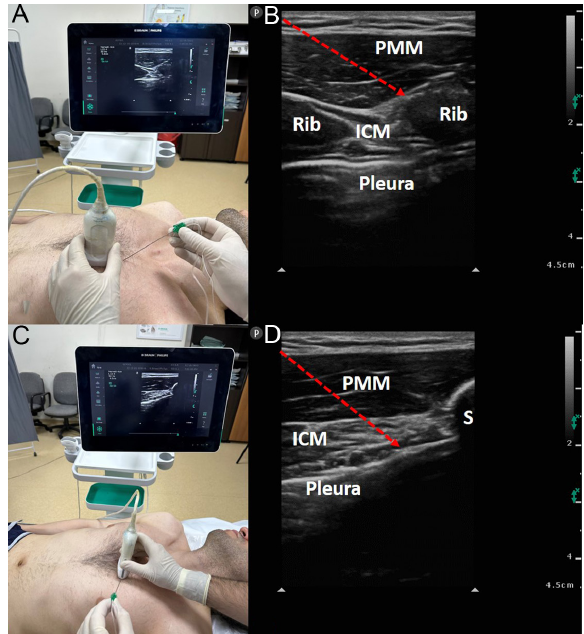
Figure 6. A-D. (A) Patient and ultrasound probe position for superficial parasternal intercostal plane block. (B) Sonographic anatomy of the superficial parasternal intercostal plane block. (C) Patient and ultrasound probe position for deep parasternal intercostal plane block. (D) Sonographic anatomy of the deep parasternal intercostal plane block. PMM, pectoralis major muscle; red arrow, needle direction.